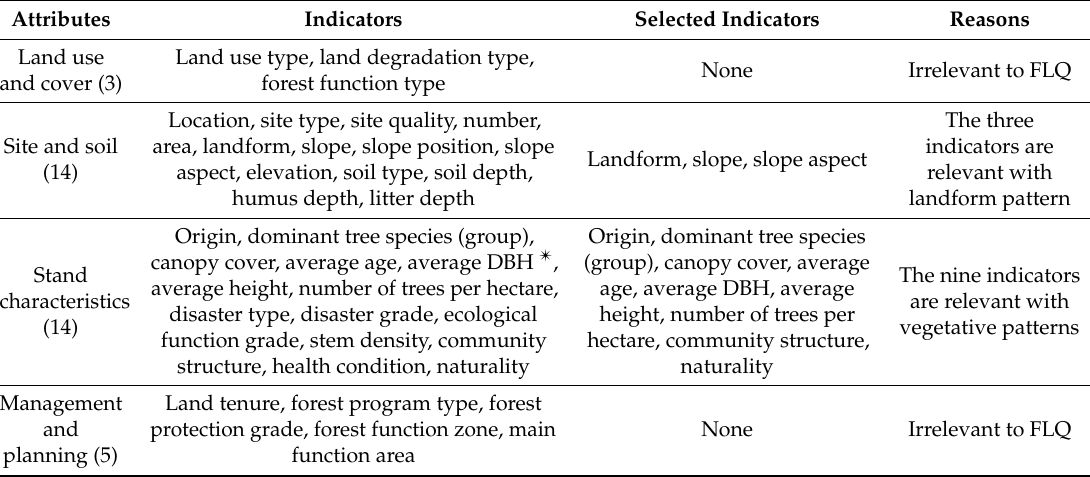
Table 1. Selection of indicators for forest landscape quality (FLQ) assessment, according to the Scenery Management System